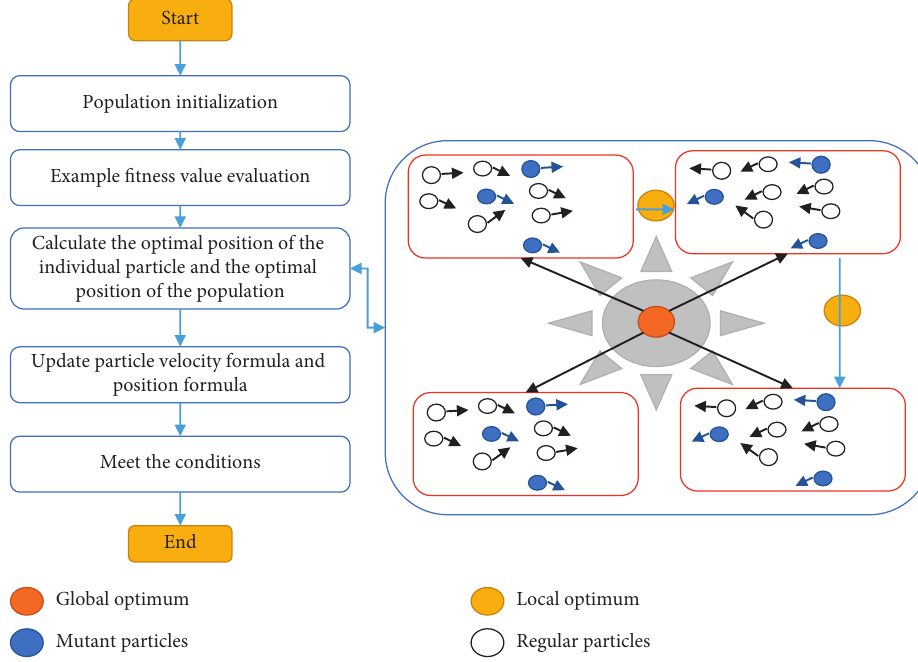
Figure 1: Flow chart of particle swarm optimization